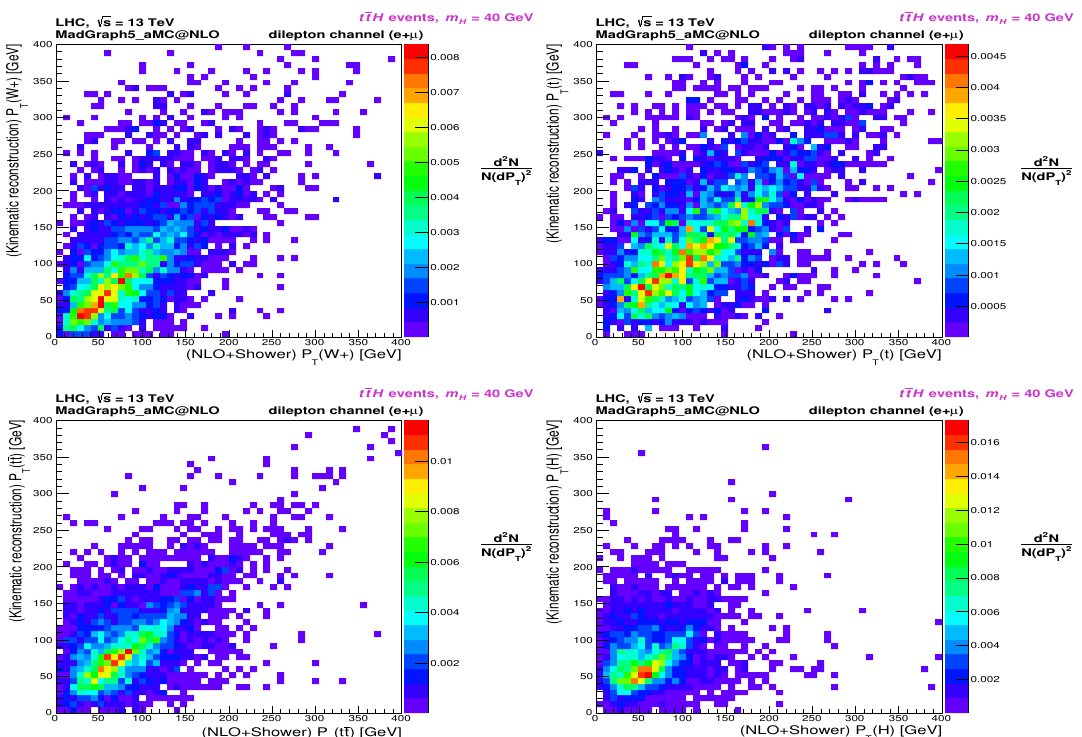
Figure 11. Two-dimensional distributions of p T in t (cid:22) tH events (similar distributions can be found for the t (cid:22) tA ). The horizontal axes represent variables recorded at NLO+Shower, and the vertical axes represent the corresponding variables after kinematic reconstruction. Upper-left: distribution for W + . A similar distribution is obtained for W (cid:0) , but is not shown here. Upper-right: distribution for t . A similar distribution is obtained for (cid:22) t , but is not shown here. Lower-left: distribution for t (cid:22) t . Lower-right: distribution for H . All distributions are shown for a Higgs mass of 40 GeV.